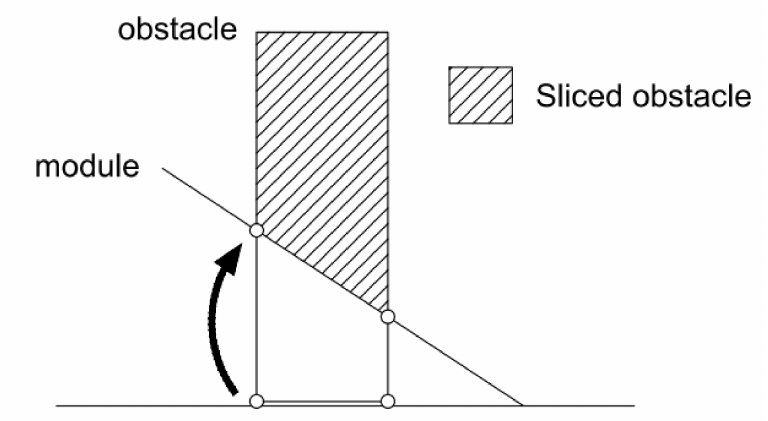
Figure 5. Side view of one module and one obstacle. If some of the obstacle vertices are behind the module plane, it is possible to slice the obstacle by moving these vertices vertically until they are positioned on the